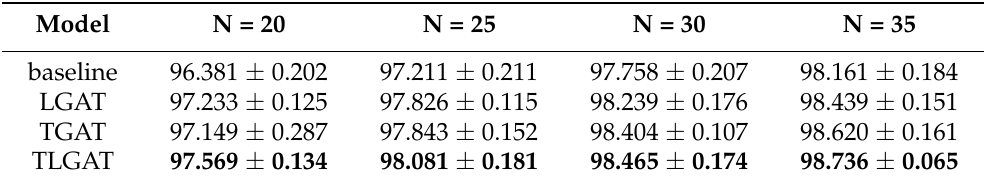
Table 8. The overall F 1 - score ( % ) (mean ± 3 σ ) of TLGAT, LGAT, TGAT, and baseline in the MILAN